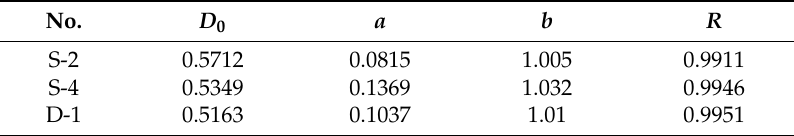
Table 3. Parameter fitting results.